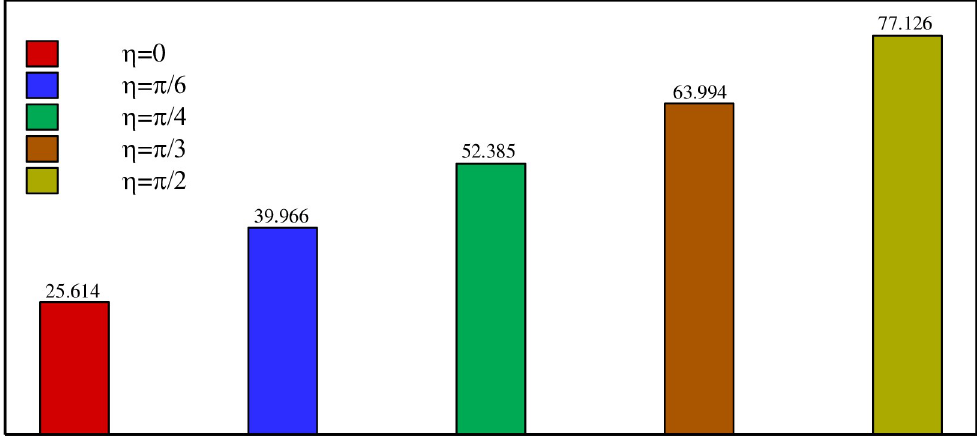
Fig 16. Comparison between the power (W/m) on various η when r